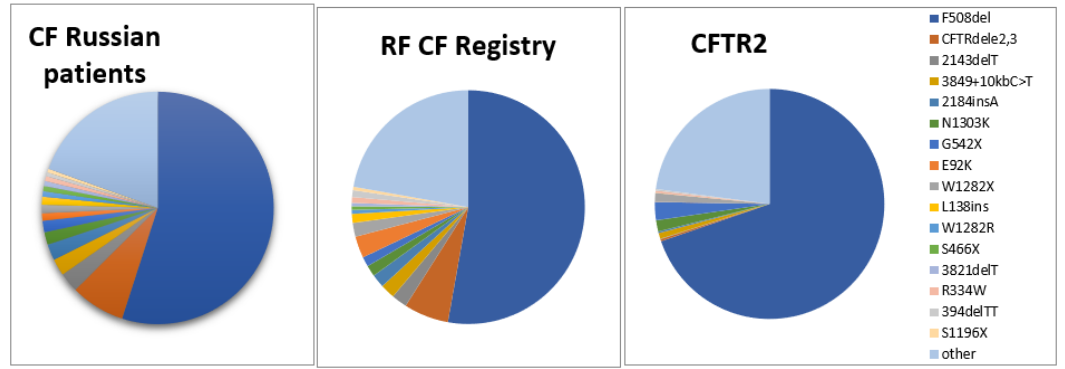
Figure 1. Frequency distribution of CFTR gene variants in three samples of CF patients: ethnic Russians, CF RF Registry, CFTR2 database [22].